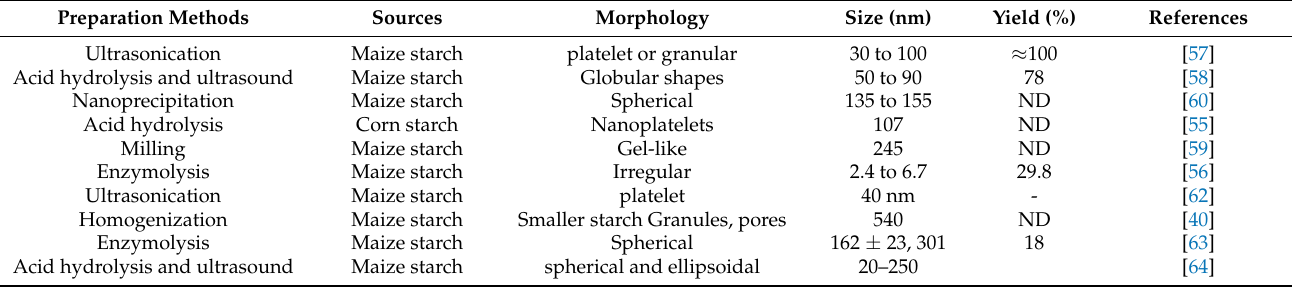
Table 1. Production rates of starch nanoparticle preparation